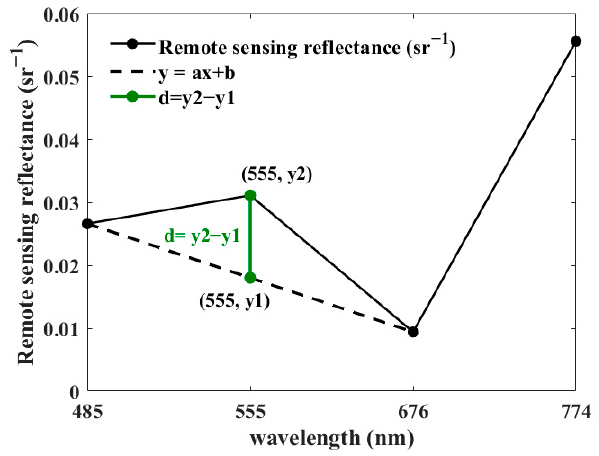
Figure 7. Spectral information of one U. prolifera pixel from GF-1 image (6 April 2021).